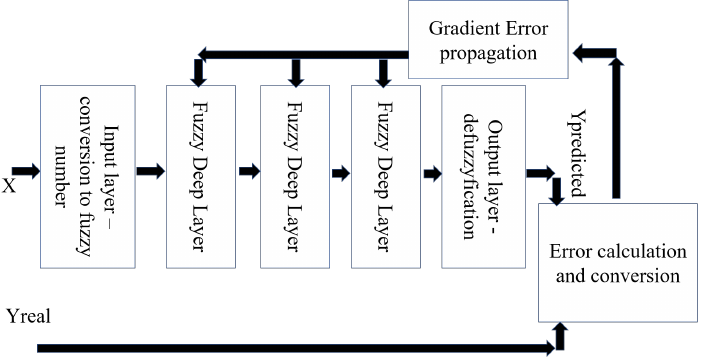
Figure 7. Second learning algorithm.